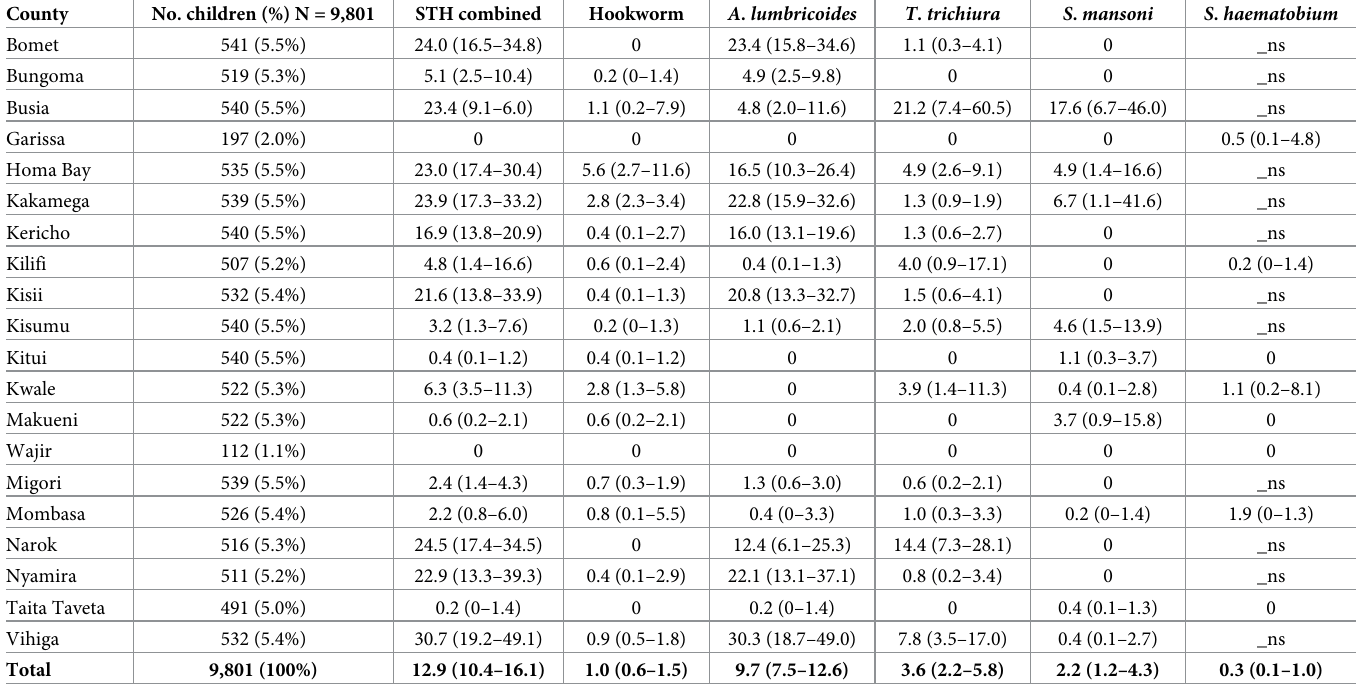
Table 4. Overall and county prevalence % (95%CI) for STH and schistosomiasis among school children in Kenya after five rounds of MDA. County No. children (%) N =